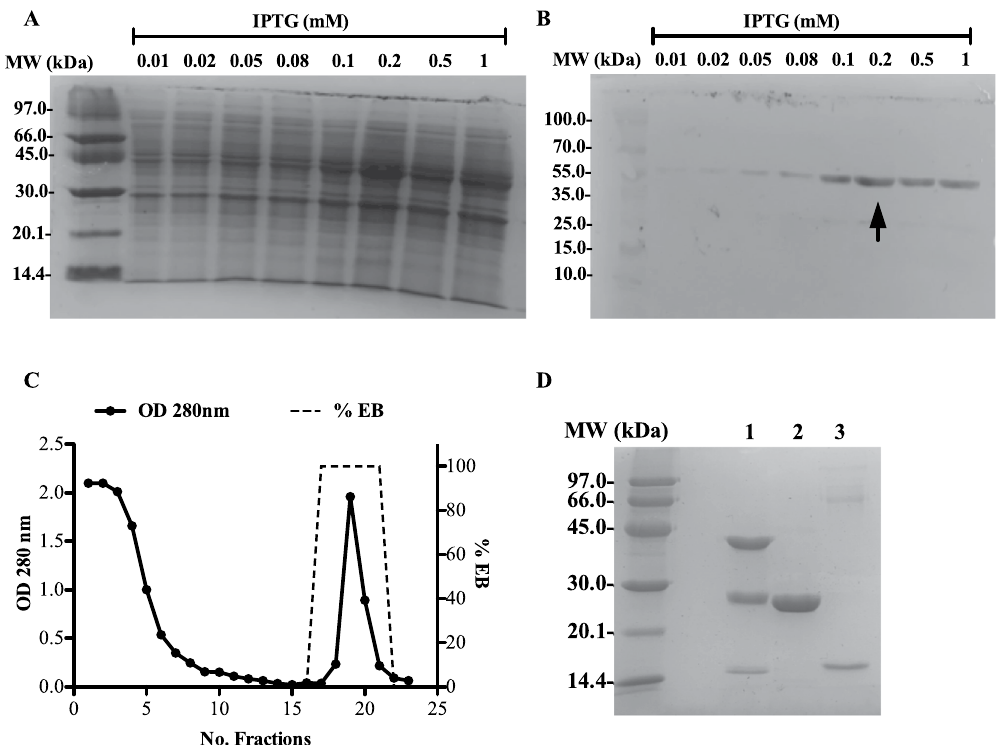
Figure 1. Optimization of the Fh15 expression in E . coli TOP10. cDNA encoding Fh15 was cloned into the pGEX-4T-2 and expressed in E . coli bacteria as a fusion protein with glutathione S-transferase (GST) of Schistosoma japonicum at the amino end of protein. Small-scale protein expression using 4-ml of LB medium was induced for 3 h at 27 °C, 225 rpm. ( A ) Bacteria lysates induced at various concentrations of IPTG were analyzed by 15% SDS-PAGE Coomassie blue stained. ( B ) Unstained gel was transferred to nitrocellulose membrane and incubated with specific anti-GST antibody labeled with peroxidase. Arrow indicates maximal expression of the GST-tagged protein estimated to be ~41–43 kDa, observed at 0.02 mM IPTG. ( C ) Fusion protein was purified from a large-scale expression culture using a GSTrap FF 5 ml column in an AKTA FPLC System. Fusion protein is eluted using the elution buffer (EB): 10 mM Tris-HCl pH 8.0 containing 10 mM GSH. ( D ) The purification process was analyzed by 15% SDS-PAGE. Lane - 1 : GST-Fh15 fusion protein, lane - 2 : GST- tag and lane - 3 : Fh15. Figure 1A,B and D represent cropped images from the original and are being displayed in black & white. Original full-length gels and blots are shown in Supplementary Figure